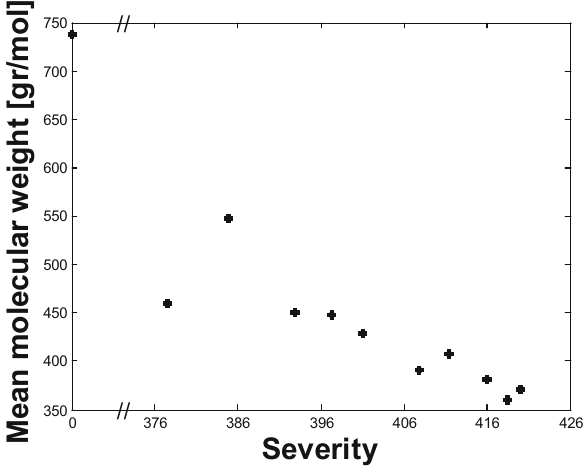
Fig. 3 Mean molecular weight as function of